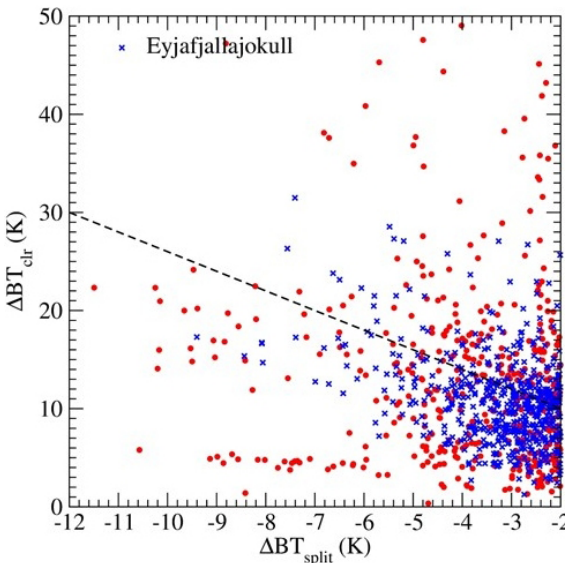
Figure 6. Estimated brightness temperature difference (cid:49) BT clr for VAC pixels of (cid:49) BT split measured with IASI. In total, 1026 pixels of (cid:49) BT split < − 2K from the volcanic eruptions listed in Table 2 were used. Data for Eyjafjallajökull eruptions (6–16 May 2010) are col- ored blue. The dashed line indicates the threshold of (cid:49) TB clr from Eq. (2) used for retrieval analysis in this